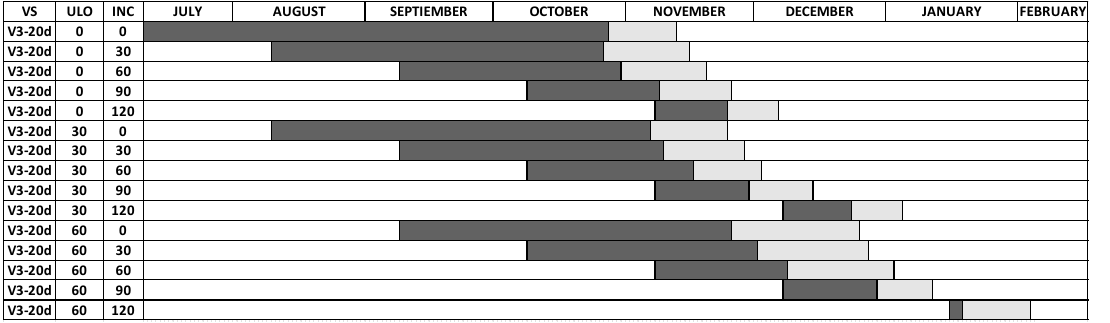
Figure 5. Calendar of flowering for corms lifted in V3–20 d, stored in ULO chambers from 0 to 60 days followed by their respective incubation times (0, 30, 60, 90 and 120 days). VS: vegetative stage; ULO: time in ULO chamber in days; INC: time in incubation conditions in days. White box: period in ULO chamber and under incubation conditions; black box: period under flowering conditions; grey box: flowering period.